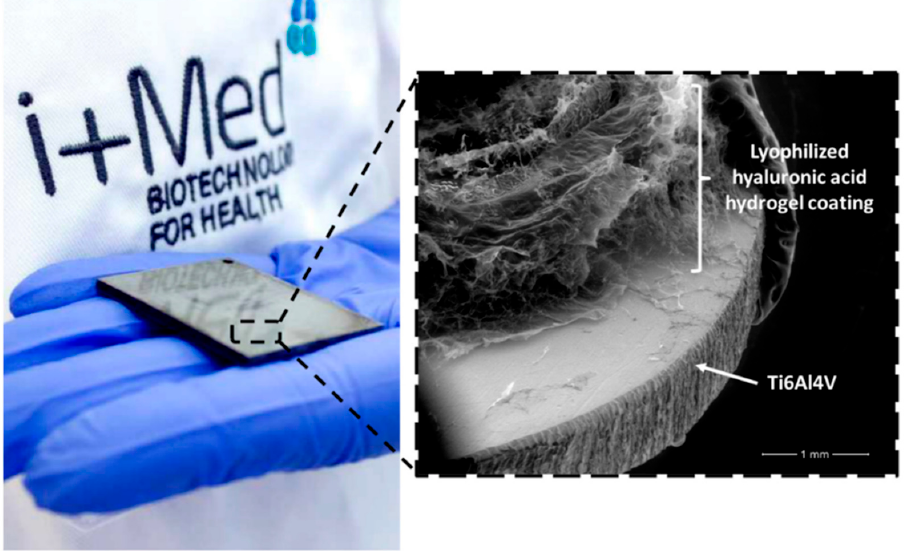
Figure 4. An illustration of a hyaluronic acid hydrogel film for putative active reagent distribution on a Ti6Al4V substrate. Reprinted with permission from [43]. Copyright 2021 MDPI. Distributed